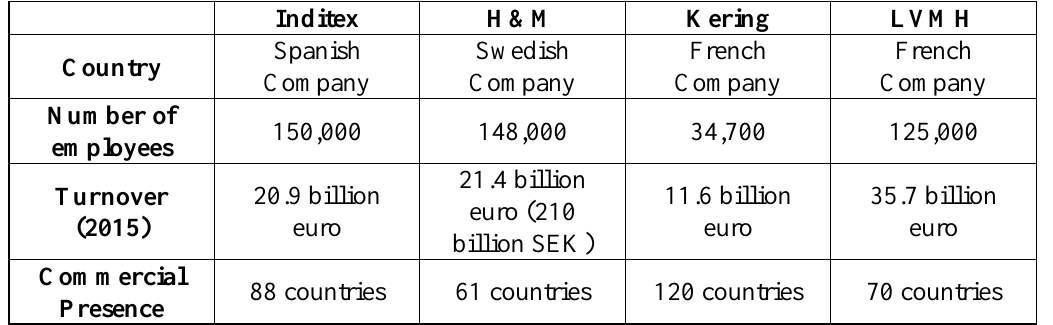
Table 1: Companies’